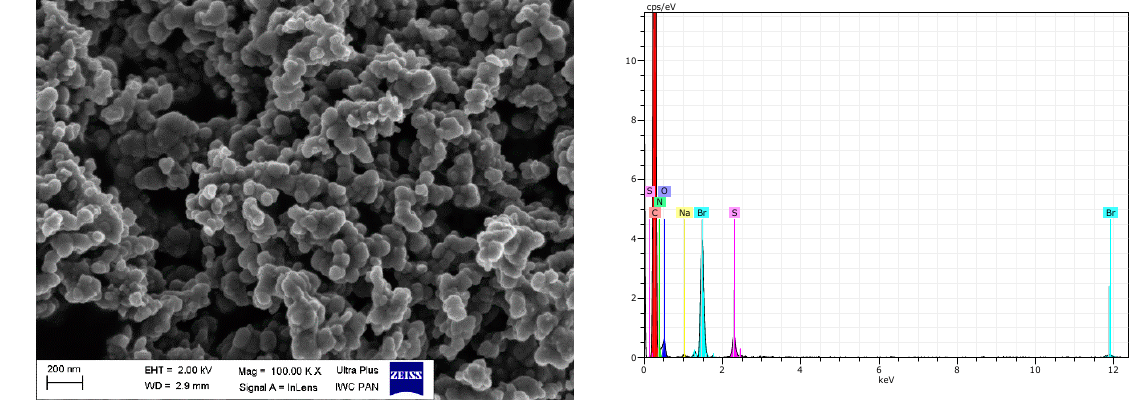
Figure 15. SEM with EDS analysis for pure CB.